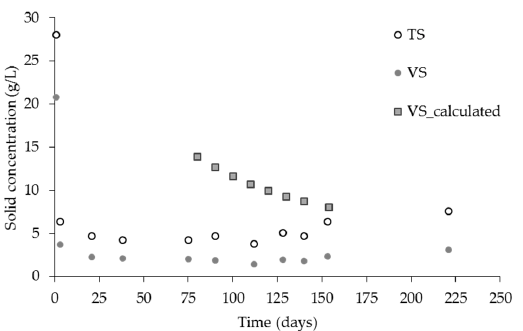
Figure 11. Representation of the solid concentration of the reactor liqueur obtained from measurements and values calculated using mass balance equations for the period between 70 and 154 days.